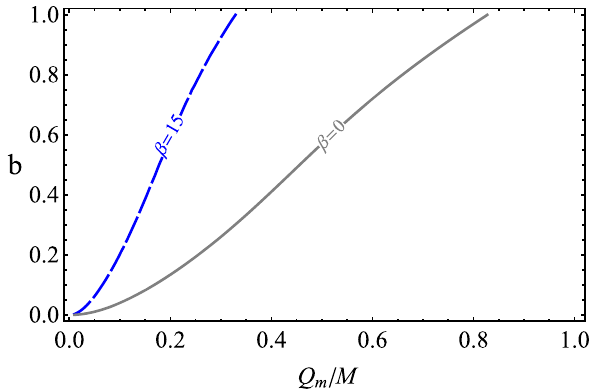
Fig. 7 Relation between magnetic interaction parameter b and mag- netic charge of the RN black hole Q m giving the same value of ISCO radius of the magnetized particles for the fixed values of the parameter β = 0 ,